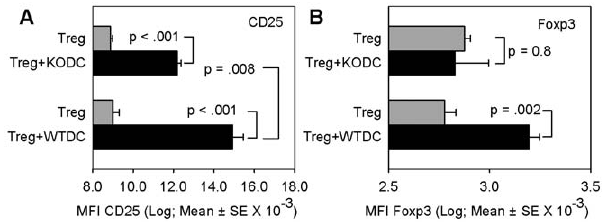
Figure 7. Dendritic cell IL-2 increases Treg phenotype. DO11.10 CD4 + CD25 + Treg cells were cultured without or with BMDCs from either WT or IL-2 2 / 2 KO (on B6 background) mice in transwells and the level of CD25 (A) and Foxp3 (B) on Treg cells was measured by flow cytometry as in materials and methods. A: Bars are the mean 6 SE of mean fluorescent intensity (MFI) of CD25 levels on Thy1.2-gated Tregs of triplicate samples from one of four representative experiments. Statistical analysis was by Tukey’s test for all pairwise comparisons. B: Bars are the mean 6 SE of mean fluorescent intensity (MFI) of Foxp3 levels on Thy1.2-gated Tregs of triplicate samples from a single experiment. Statistical analysis was by Tukey’s test for all pairwise